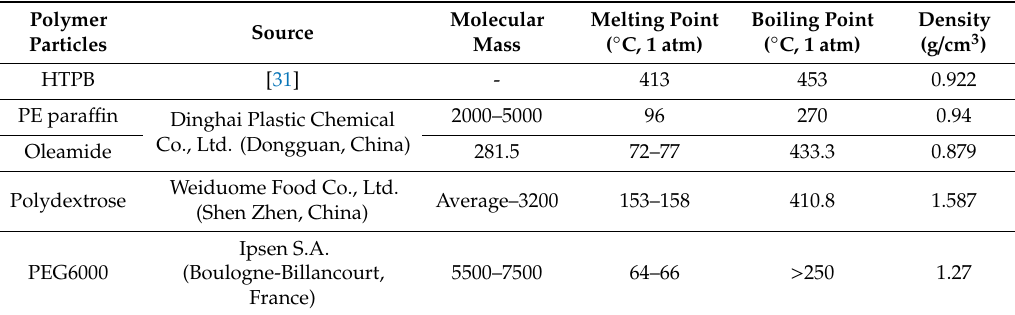
Table 1. Physical properties of the tested polymer particles.